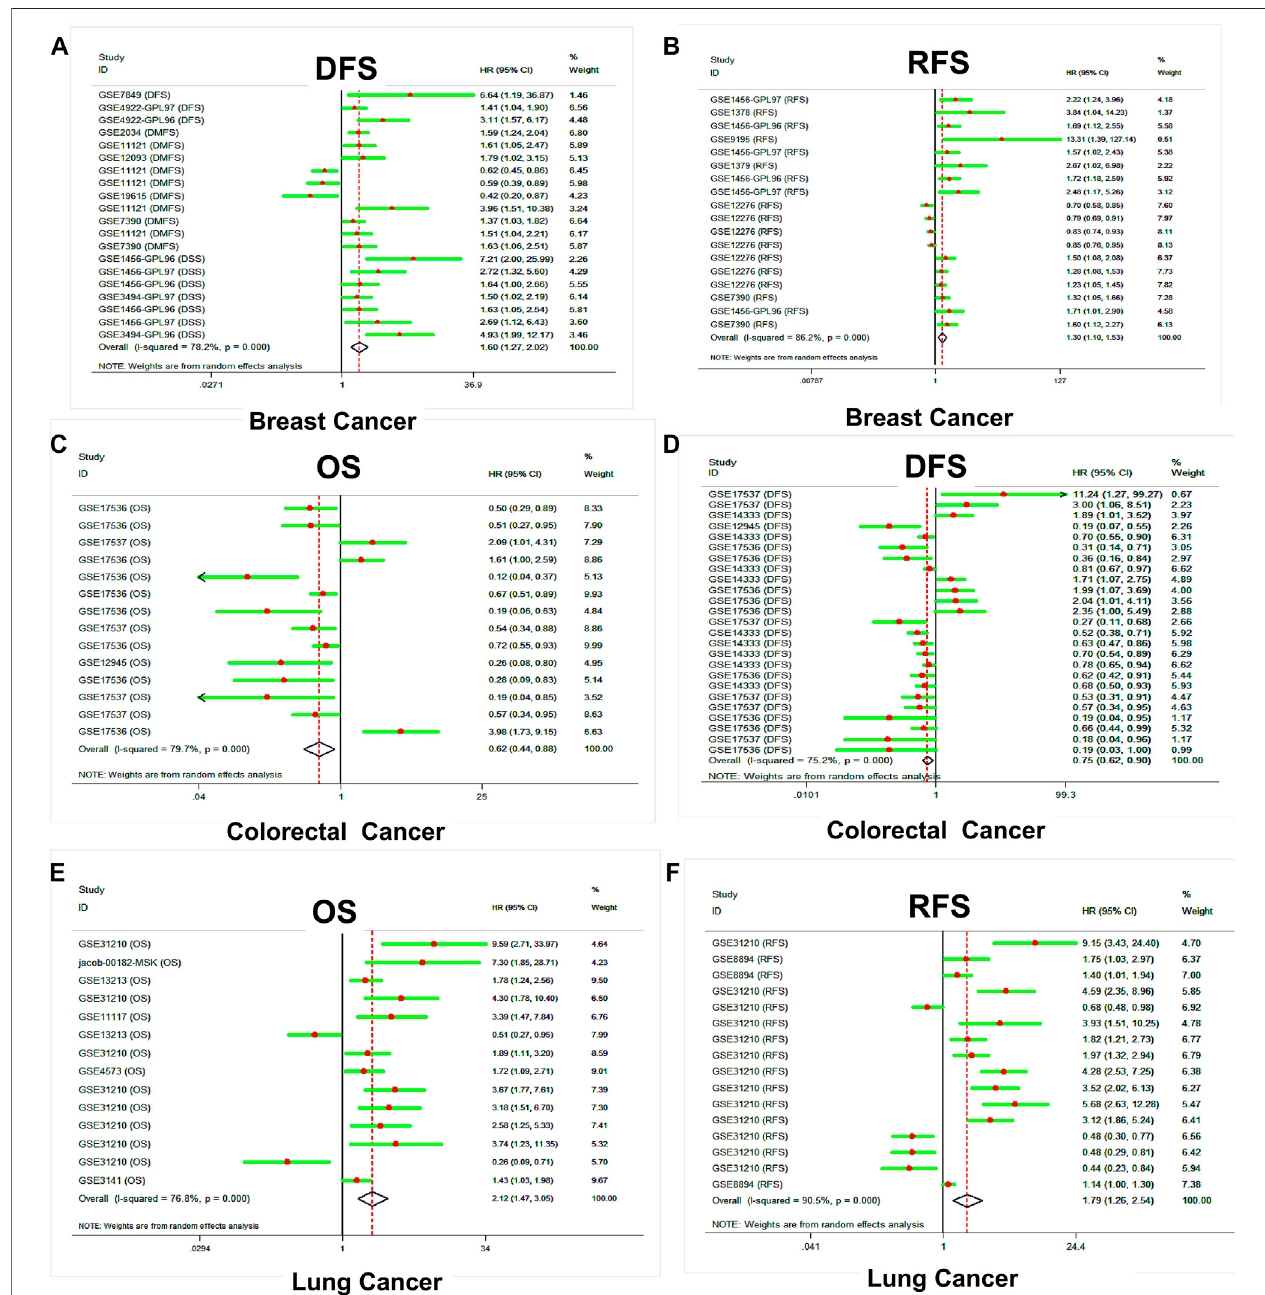
FIGURE5| Survivalanalysisoftheprognosticvalueofthe SLC39A familygenesinpan-cancerderivedfromthePrognoScandataset. (A) ForestplotofDDSshows the effect of SLC39A family geneexpression on theclinical prognosis ofbreast cancer. (B) Forest plot ofRFS shows theeffectof SLC39A family gene expression on the clinicalprognosisofbreastcancer. (C) ForestplotofOSshowstheeffectof SLC39A familygeneexpressionontheclinicalprognosisofcolorectalcancer. (D) Forestplot of DFS shows the effect of SLC39A family gene expression on the clinical prognosis of colorectal cancer. (E) Forest plot of OS shows the effect of SLC39A family gene expression on the clinical prognosis of lung cancer. (F) Forest plot of DFS shows the effect of SLC39A family gene expression on the clinical prognosis of lung cancer.